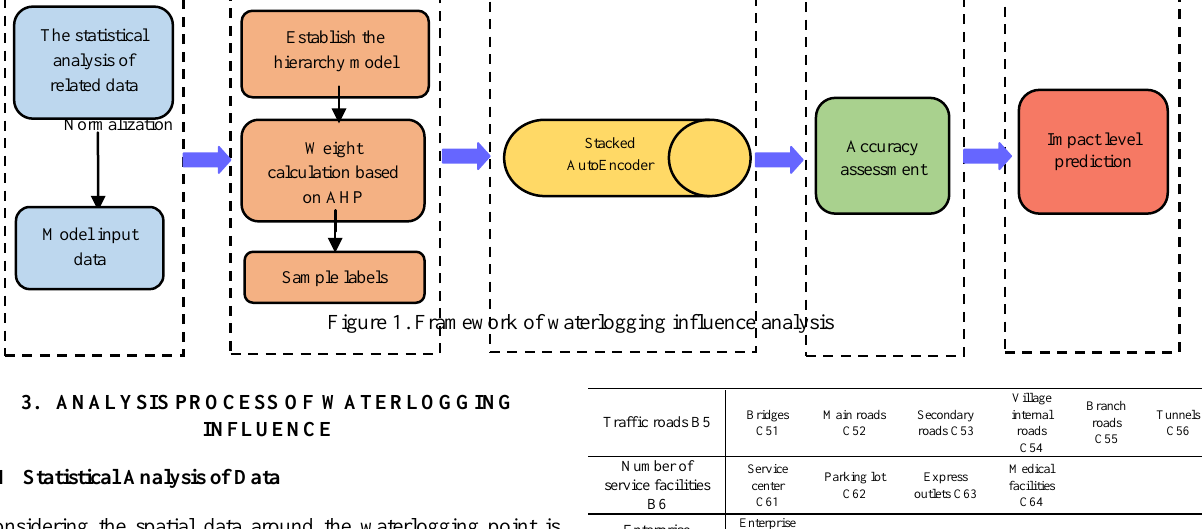
Figure 1. Framework of waterlogging influence analysis